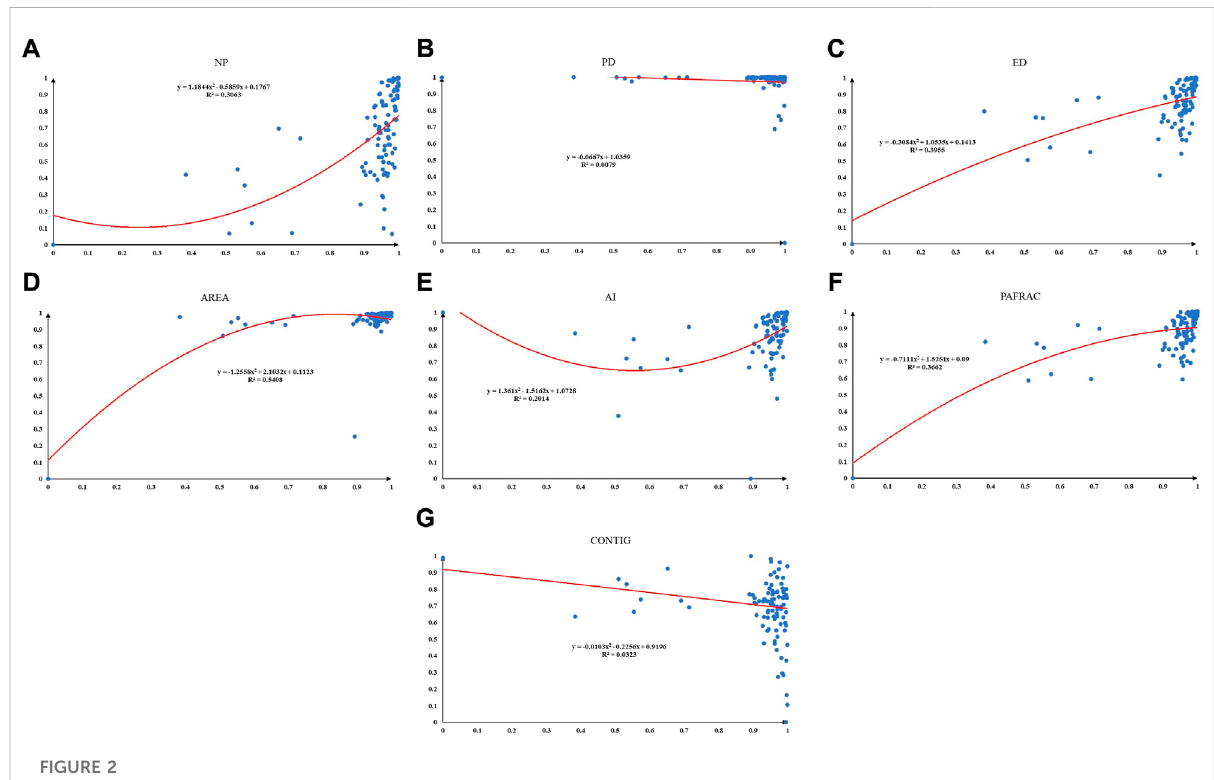
FIGURE 2 (A-G) Correlation coef fi